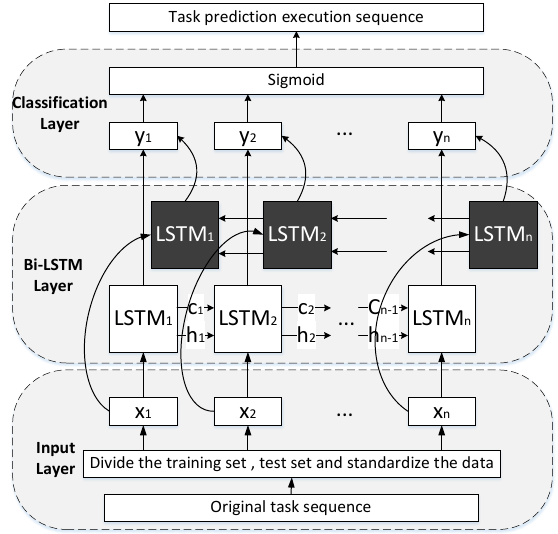
Figure 4. Bi-LSTM predictive model structure.